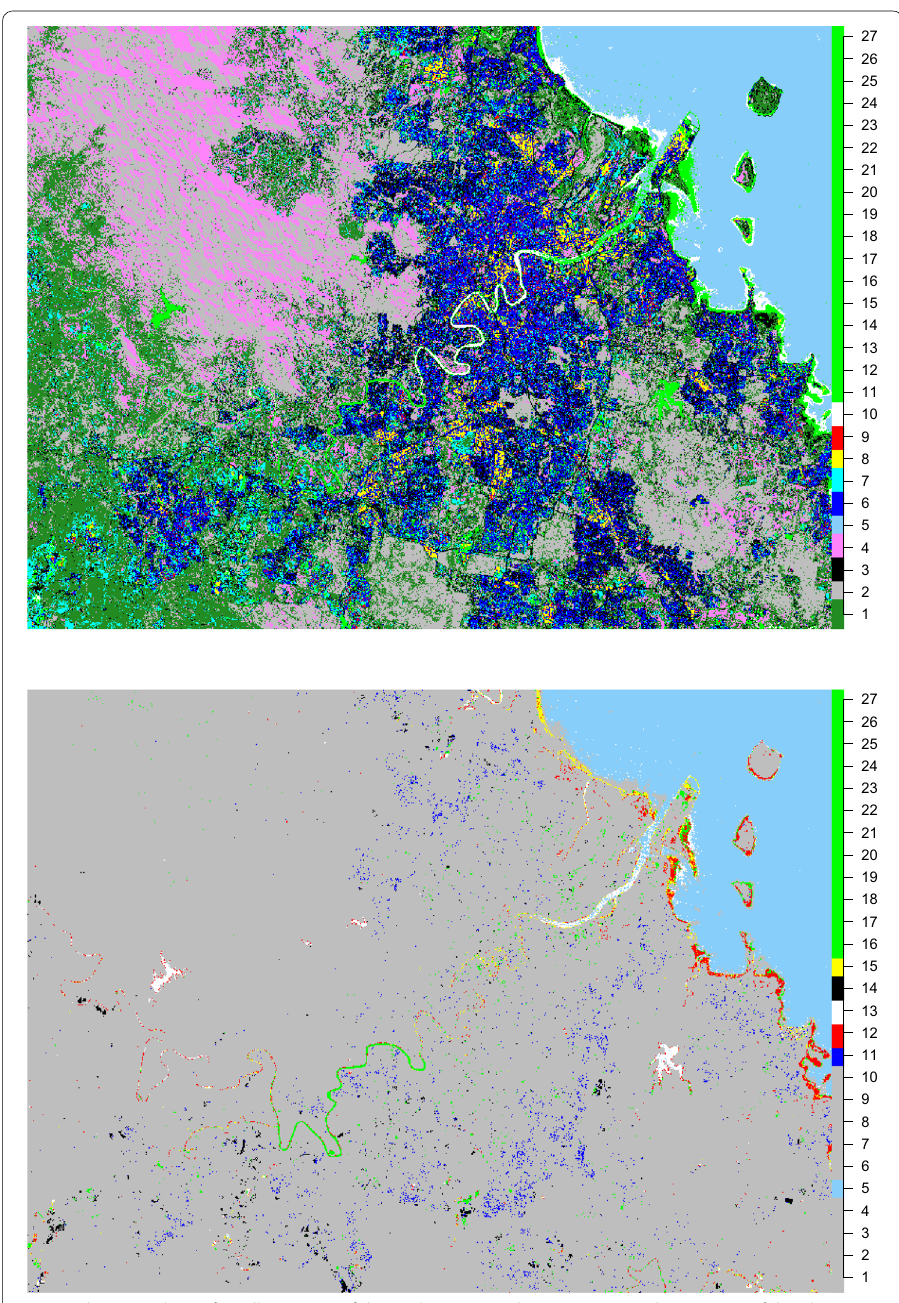
Fig. 8 Cluster analysis of satellite image of the Brisbane area taken in 2010. For clarity, some of the clusters are merged together in bright-green clolour and the results are presented in two plots: (left penal) 1: scrub-land or bare ground, 2: forest, 3: roads and old residential areas, 4: mountain and forest mixed with playgrounds, 5: water, 6: residential areas, 7: bare ground and impervious surfaces, 8: commertial buildings, 9: residential area (with bright steel roofing) mixed with commercial buildings, 10: seashore; (right penal) 5: water, 11: new residential areas, 12: water and seashore, 13: water, 14: disturbed earth, 15: water and